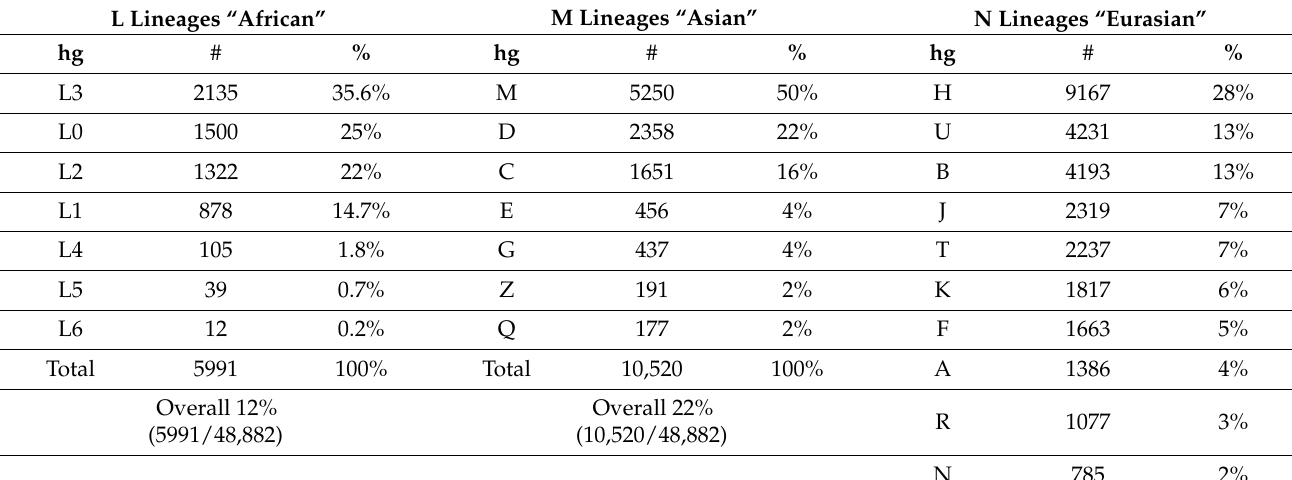
Table 7. Lineage distribution of 48,882 sequences addressed in ForenSeq mtDNA primer design [46]. L Lineages “African” M Lineages “Asian” N Lineages